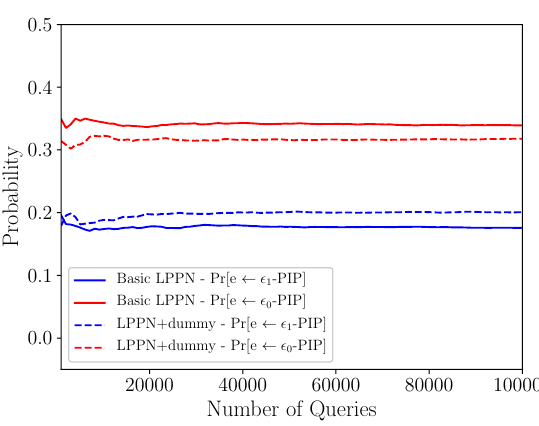
Figure 8: Output dependency on the proposed LPPN implementations.